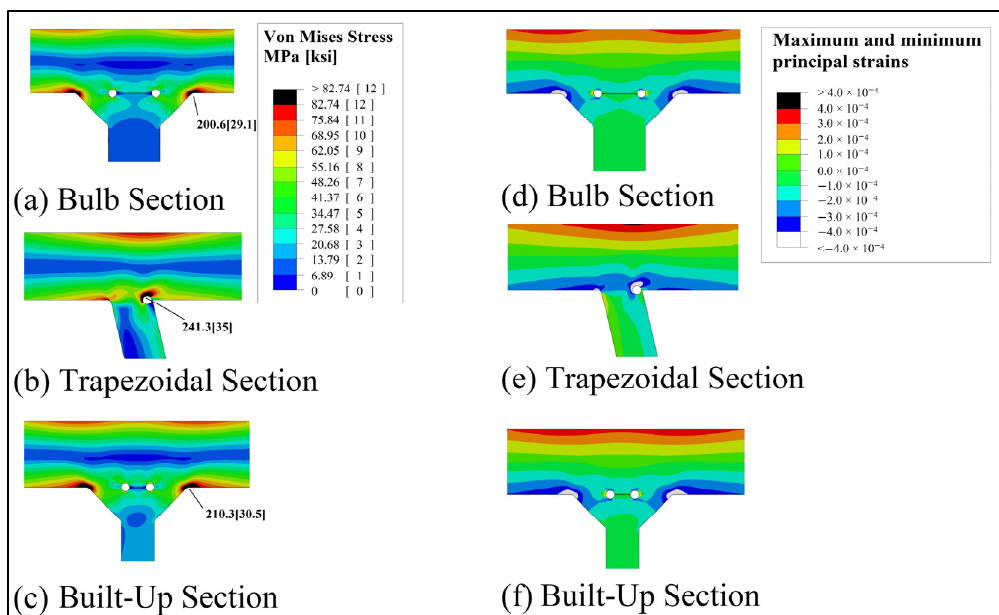
Figure 15. Panel/rib joint Von Mises stress and maximum principal strain distributions from plane strain analysis.